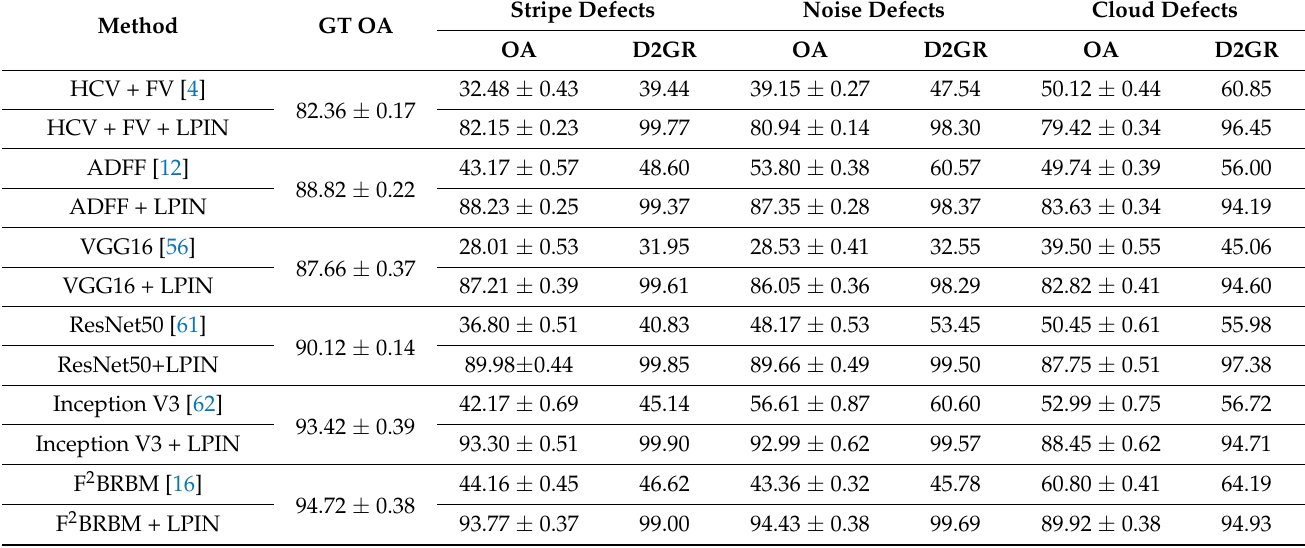
Table 4. OA (%) and DR (%) of Six Classifiers and Corresponding Combined Methods with LPIN on NWPU-RSISC45